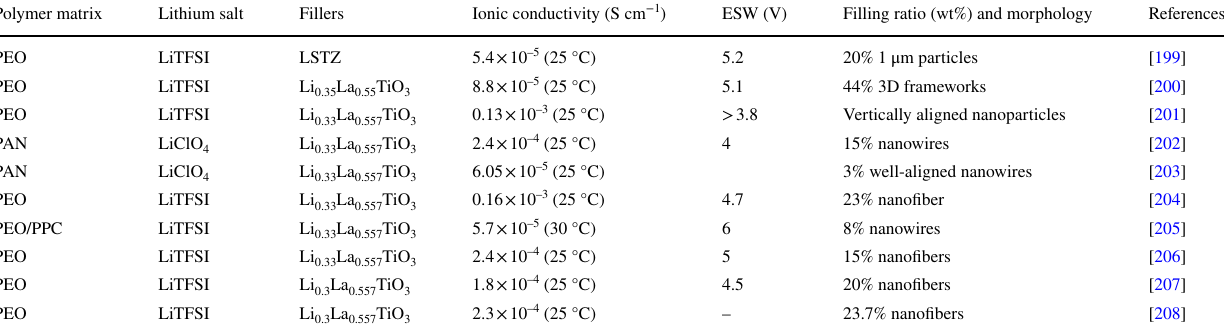
Table 5 PIEs filled with perovskite-type fillers and their properties Polymer matrix